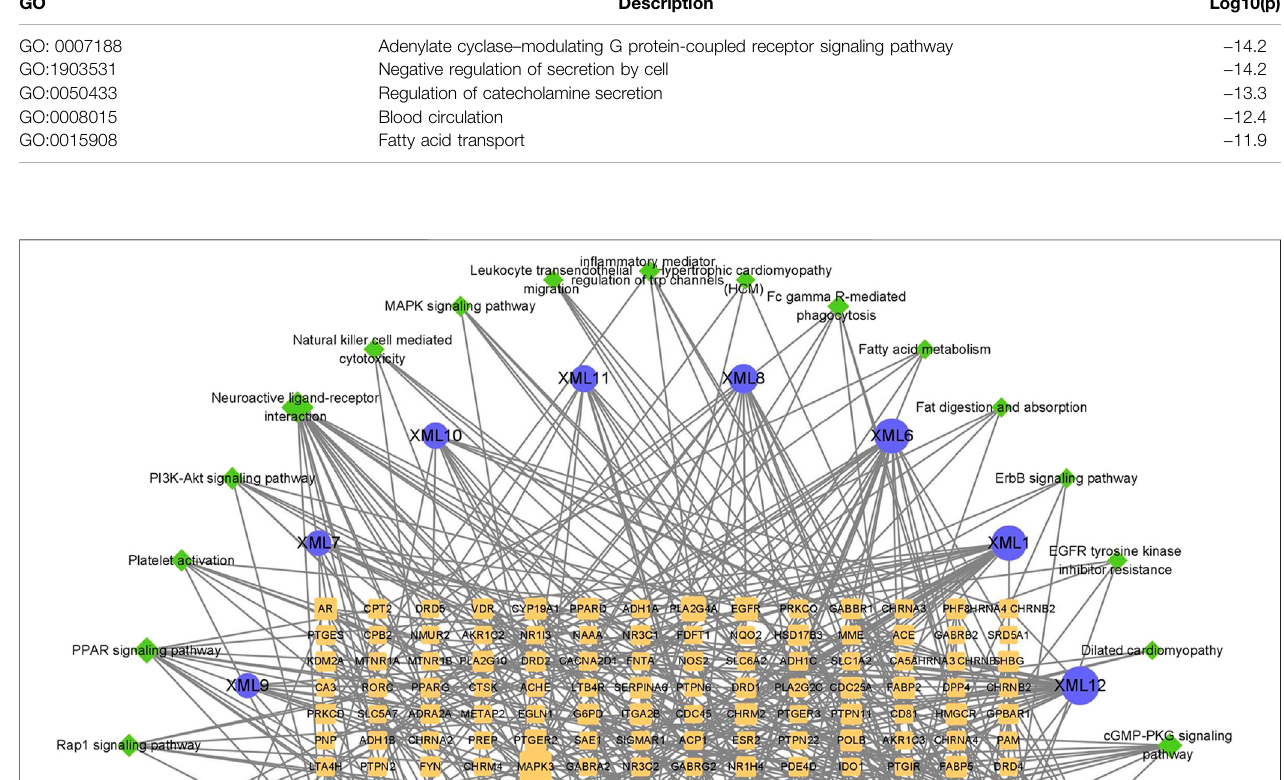
Frontiers in Cell and Developmental Biology |